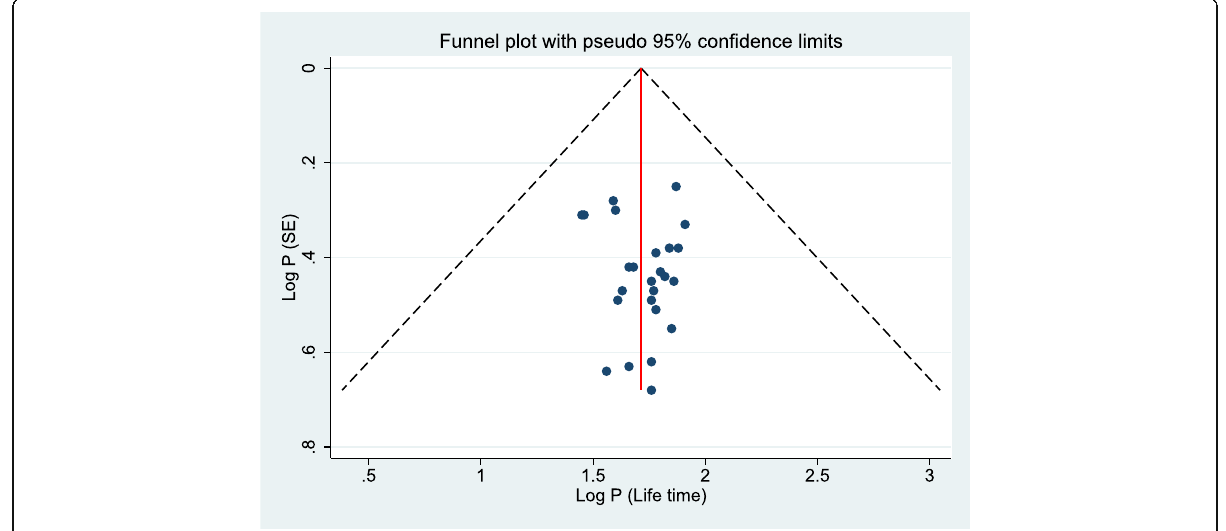
Fig. 5 Publication bias of lifetime prevalence of BBFs exposure among HCWs in Ethiopia,